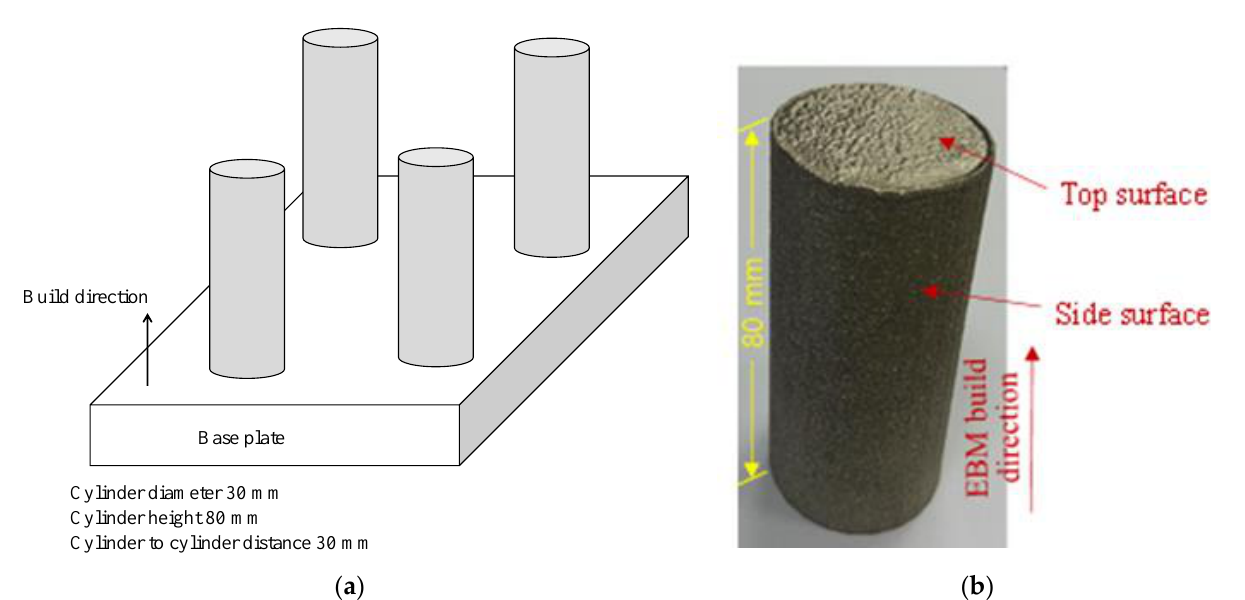
Figure 1. ( a ) Schematics of the parts layout for Electron Beam Melting (EBM) operations, ( b ) actual γ-TiAl cylinder fabricated by EBM.